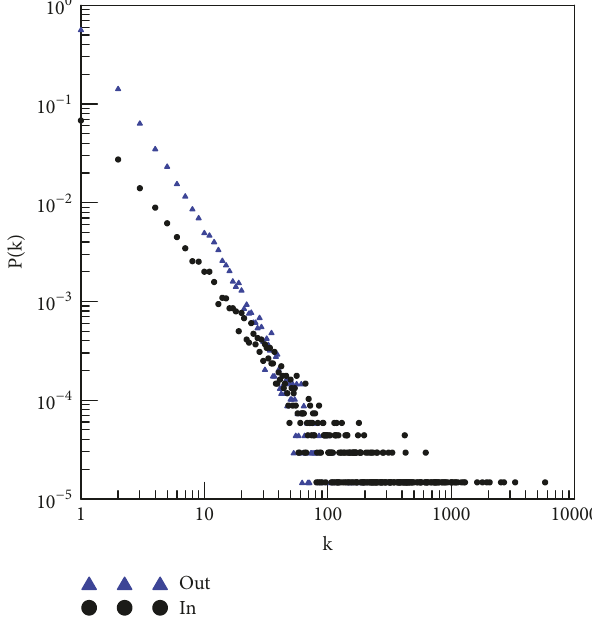
Figure 4: Indegree and outdegree distributions corresponding to the retweet network for the period 11-17 December, 2017.